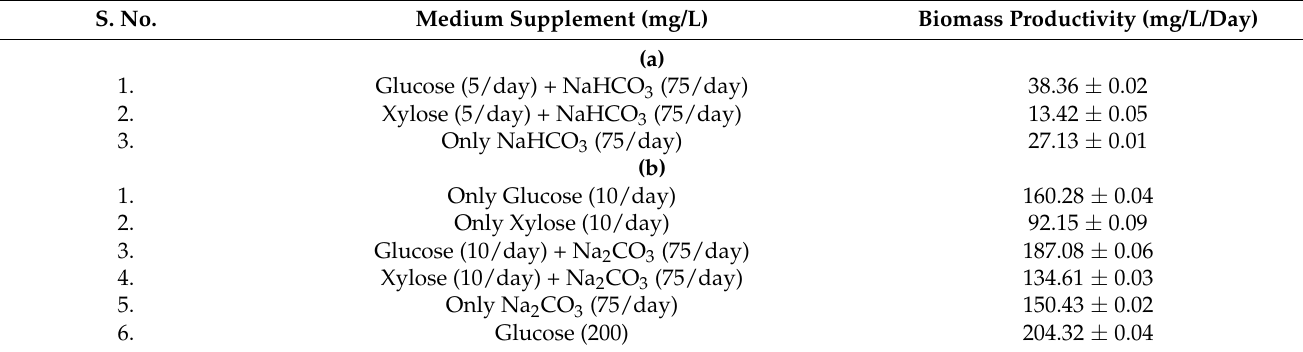
Table 4. Change in cell density of (a) Chlorella sorokiniana 1 (isolated from BG-11 medium pH-9); (b) Chlorella sorokiniana 2 (isolated from Knop’s medium pH-9), when grown in synthetic hydrolysate supplemented with different monosaccharides under 12 h:12 h light–dark cycle (light intensity: 221 µ mol/s/m 2 ). S.